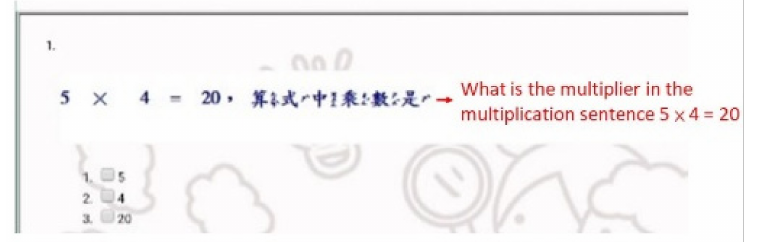
Figure 3. Student is taking an online test in the